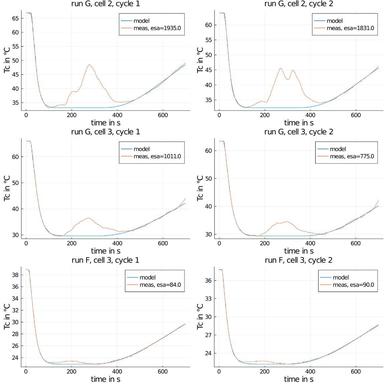
Temperature profiles in run G, showing a non-smooth drying curve and a large error value esa compared to the temperature profiles in run F with a smooth drying curve.